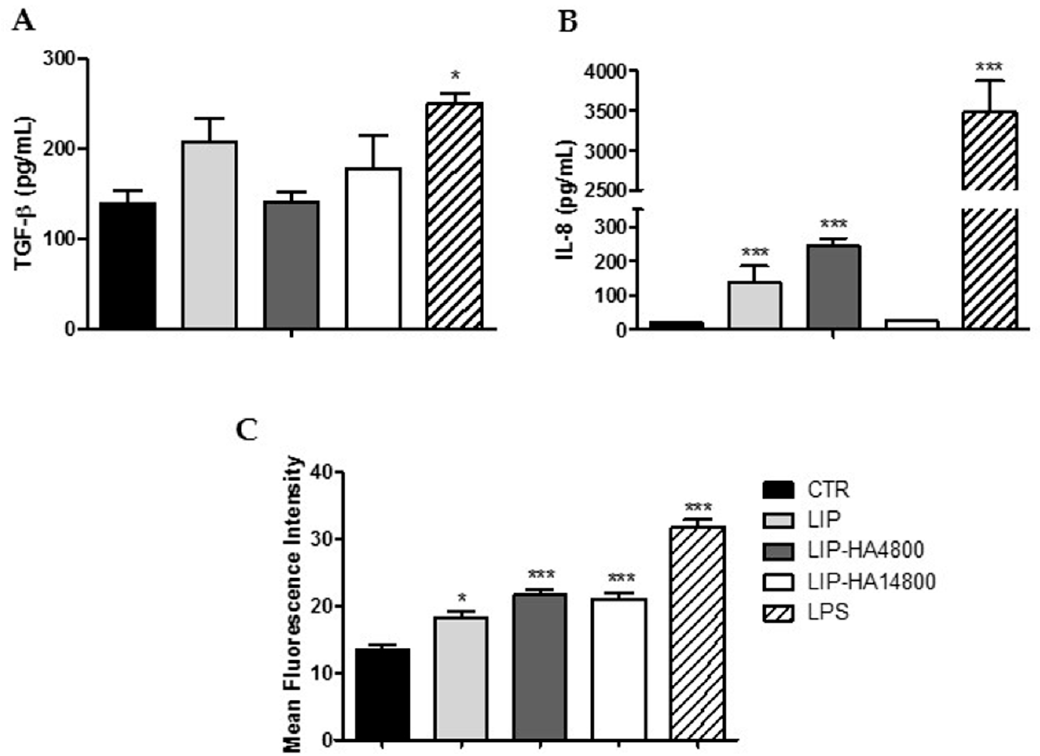
Figure 6. Liposomes biological effects on TGF- β ( A ) and IL-8 ( B ) release by monocytes isolated from peripheral blood. Analyses of CD11b surface expression on neutrophils by flow cytometer. All analyses were conducted after treating cells with LIP, LIP-HA4800 and LIP-HA14800 after 24 h for monocytes ( A and B ) and 4 h for neutrophils ( C ). LPS treatment was used as control. Data are represented as histograms of mean ± standard deviation. *, p < 0.05 vs. CTR; ***, p < 0.001 vs. CTR.